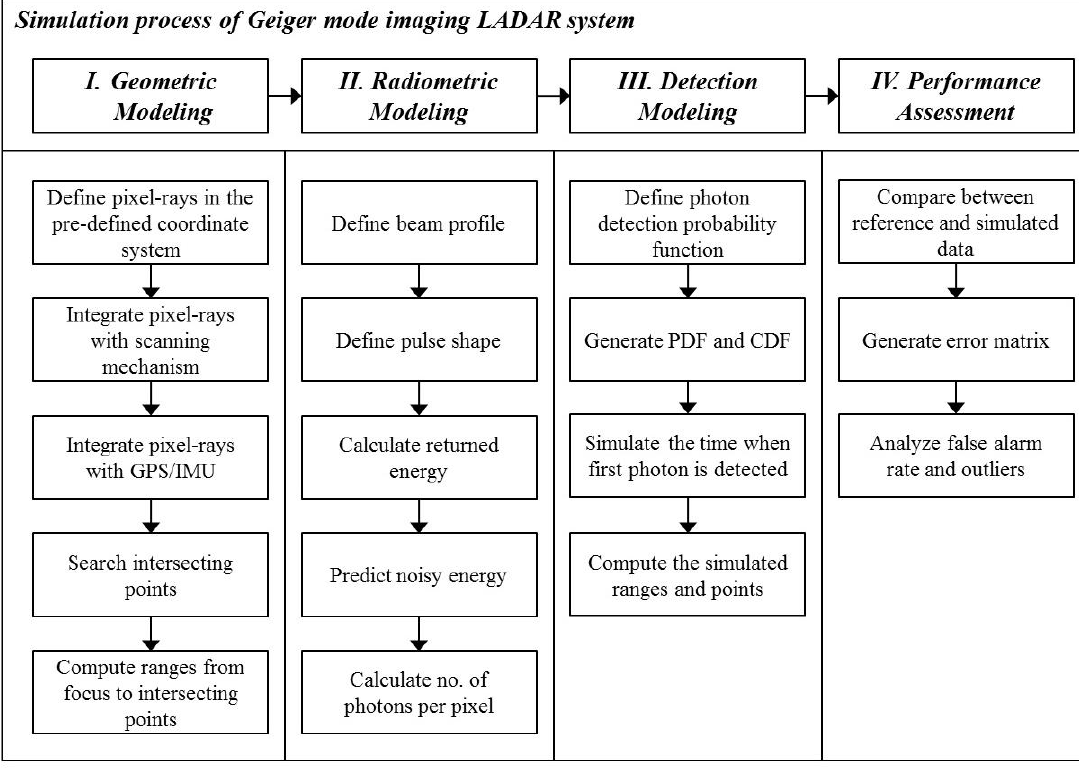
Figure 2. Simulation process of Geiger-mode imaging LADAR. Geometric model finds where the information of each pixel comes from. Radiometric model computes how much energy strikes the pixels, including noise energies. Detection model generates the simulated time when the first photon is detected based on a probability function. Simulated point cloud was compared point by point to the reference data generated in the geometric